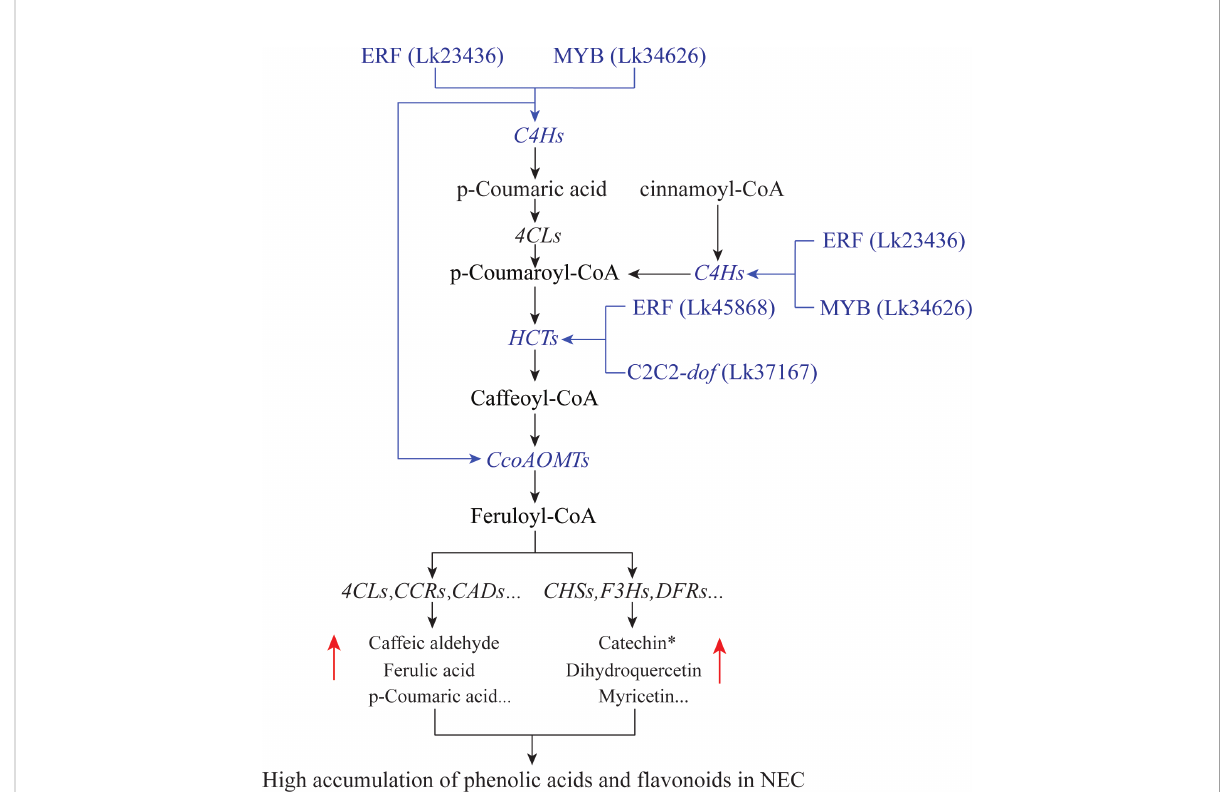
FIGURE 11 Potential transcriptional regulatory module governing the differential accumulation of fl avonoids and phenolic acids between EC and NEC. Possible regulatory modules were highlighted in